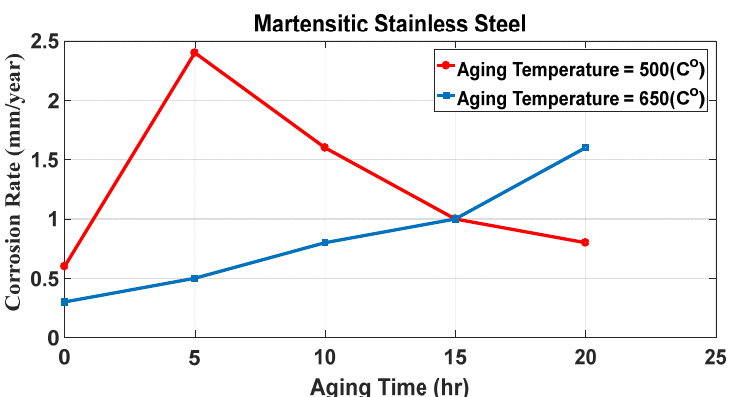
Fig. 13. Effect of aging time on the chemical corrosion rate of aging samples at an aging temperature of (500 and 650) °C from the accelerometer test (dynamic voltage test).